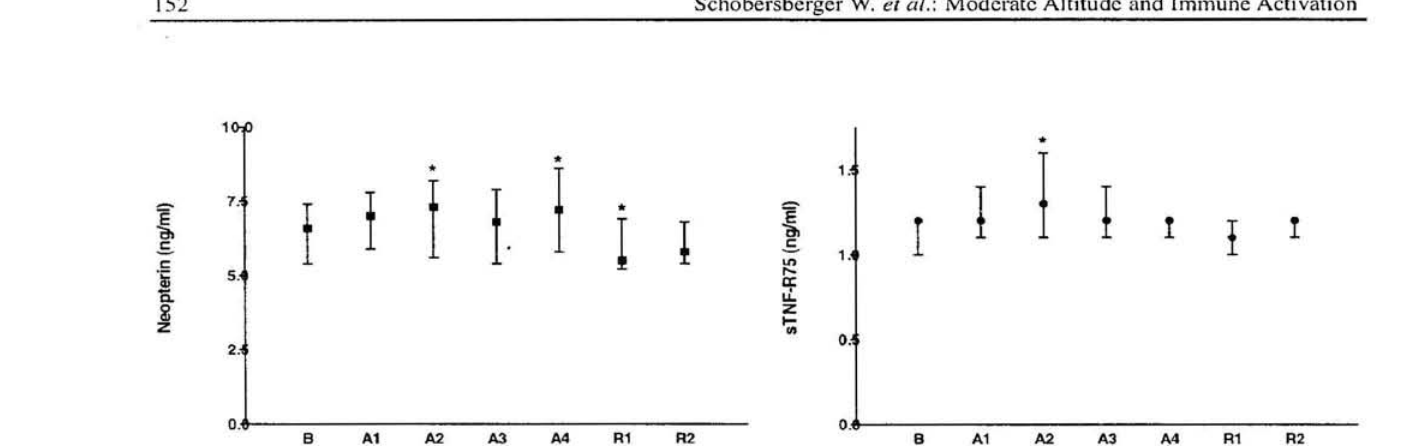
Figure 1. Time course of changes in neopterin serum concentrations (ng/ml) in 22 male subjects with meta- bolic Syndrome before (B), during day 1 (AI), day 4 (A2), day 9 (A3), and day 19 (A4), and after sojourn at moderate altitude (1700 m above sea-level) as well as post-altitude 1 week (Rl) and 6-7 weeks (R2) follo- wing return to 500m above sea-level. Values are shown as medians with the 25"' and the 75"' percentile. *P<0.05 as compared to baseline values (B).